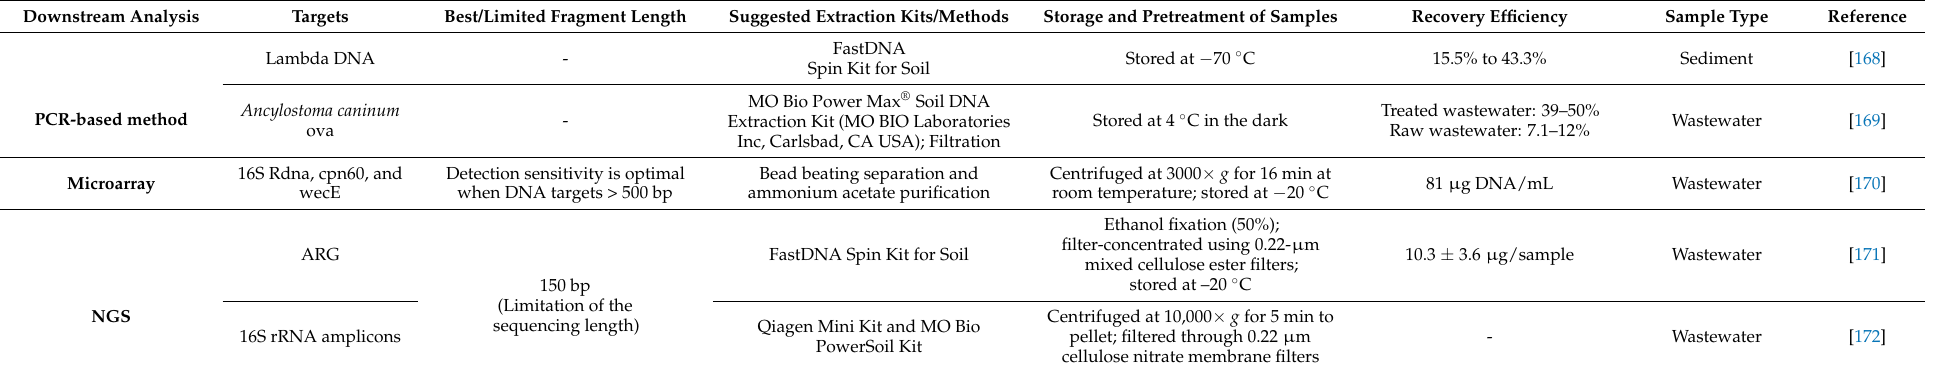
Table 3. Comparison studies of DNA/RNA extraction methods for various downstream molecular methods of wastewater and sediment